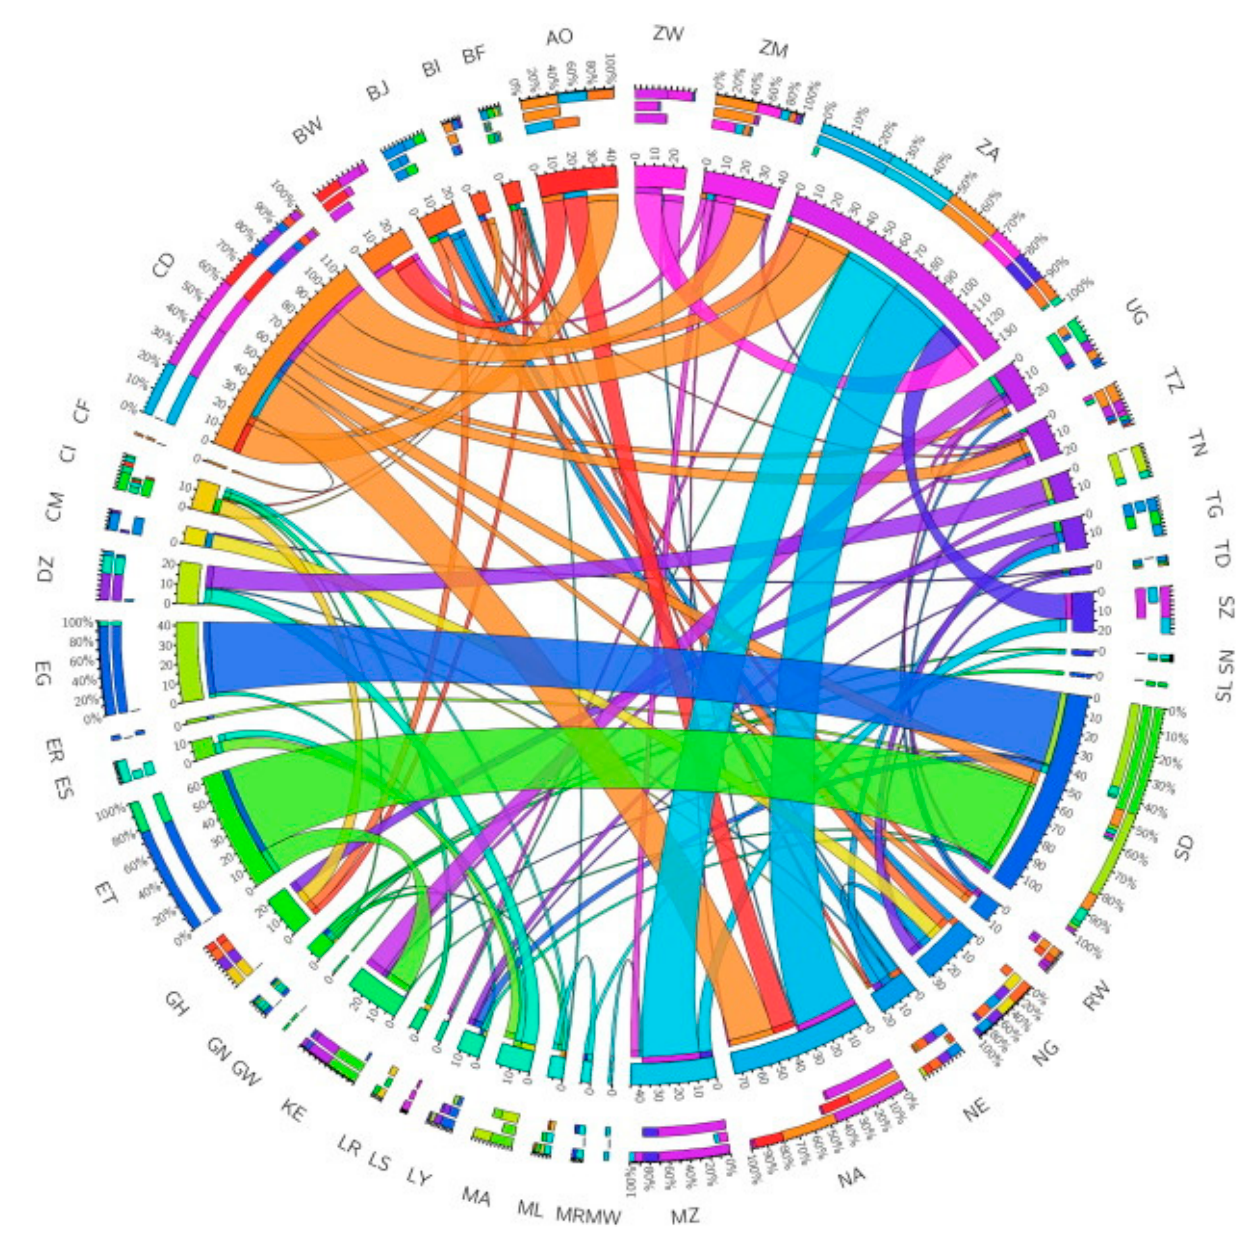
Figure 6. Inter-region power trade with unlimited power trade expansion in 2040. Source Taliotis et al. [22]. The ‘chord’ diagram represents an Africa-wide trade scenario, with free trade to be radically increased over current levels. Each continental African country with power trade is represented. A country is assigned a color indicated by the broadest ‘ring’ adjacent to its two-letter country code. Electricity trade between countries is indicated by ribbons connecting each country. The color of the ribbon indicates the country of origin. Total trade percentages, import percentages and export percentages are indicated by the outermost, second outermost and third outermost rings, respectively. In the source study of the diagram (undertaken without consideration of the climate constraints analyzed here, and with different underlying assumption) we see Zimbabwe (ZW) may trade 25% of its power. In the scenario, there are imports from Zambia (ZM) and Angola (NA), most of which is exported to South Africa (ZA). Future work must take cognizance of